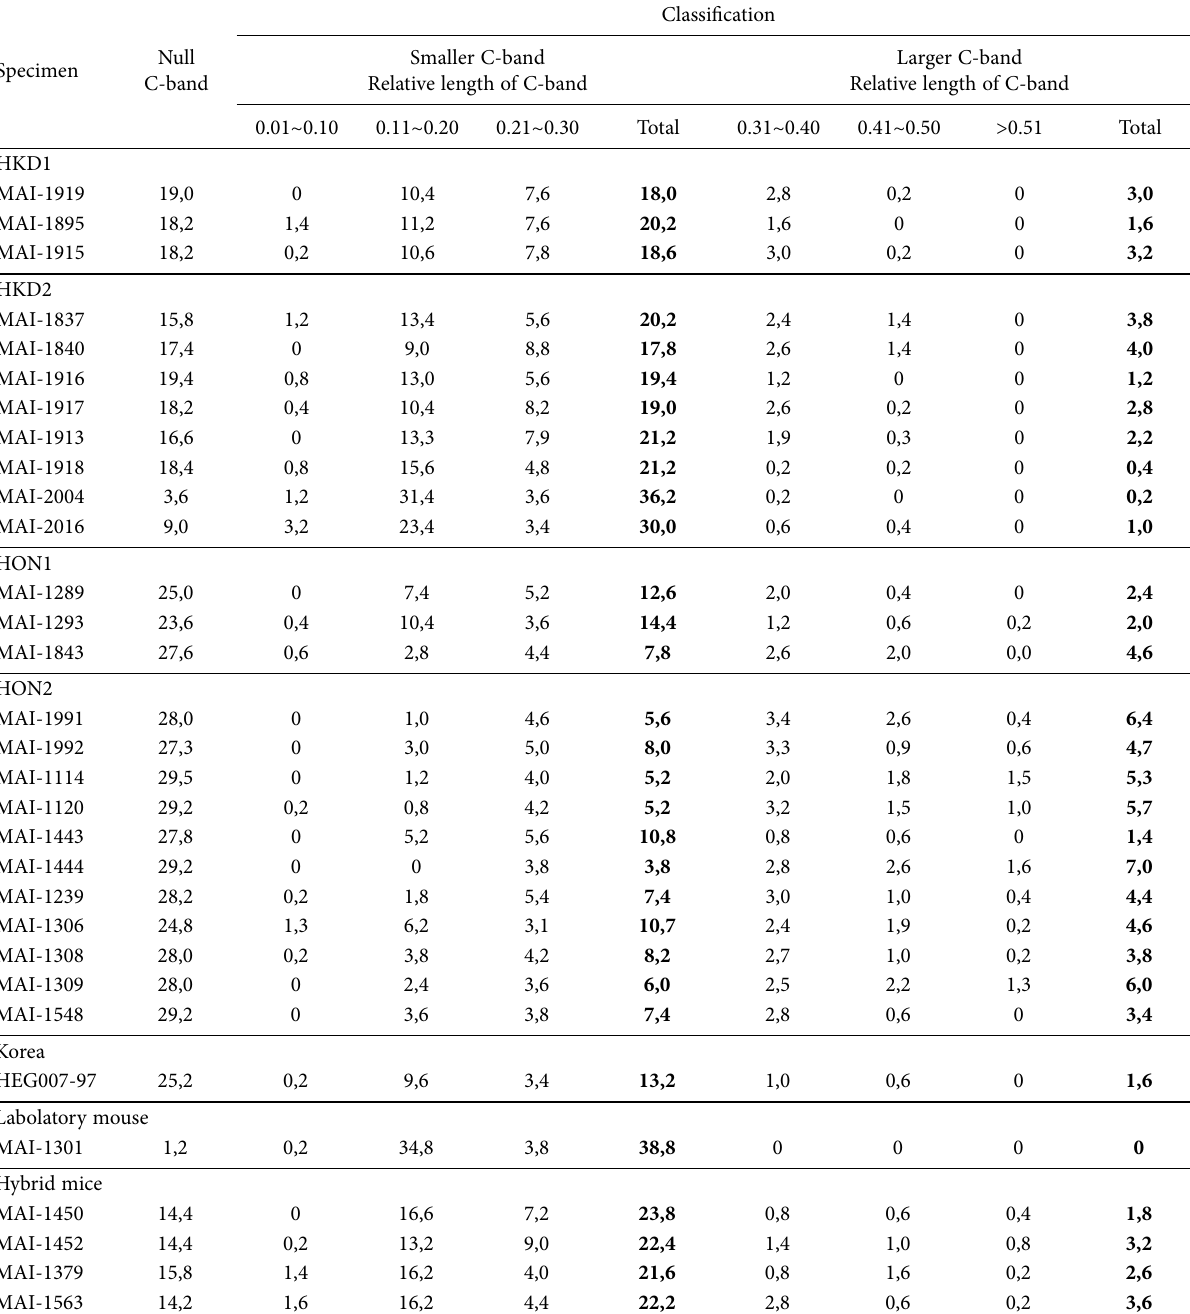
Table 2. Mean numbers of chromosomes with null C-band and C-band classified into each class of relative length.